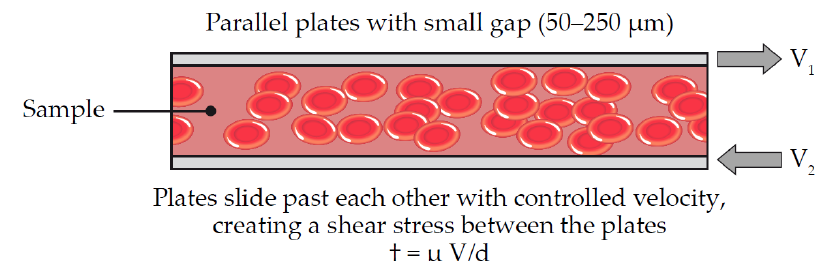
Figure 11. Parallel plate viscometry. Parallel plates slide past each other with controlled velocity to create a shear stress between the plates, which is represented as † = µ V / d, where † = shear stress; µ = viscosity, V = V 1 − V 2, (relative linear velocity of the plates); d = gap between plates. Adapted from US Patent 8,450,078 B2 [39].